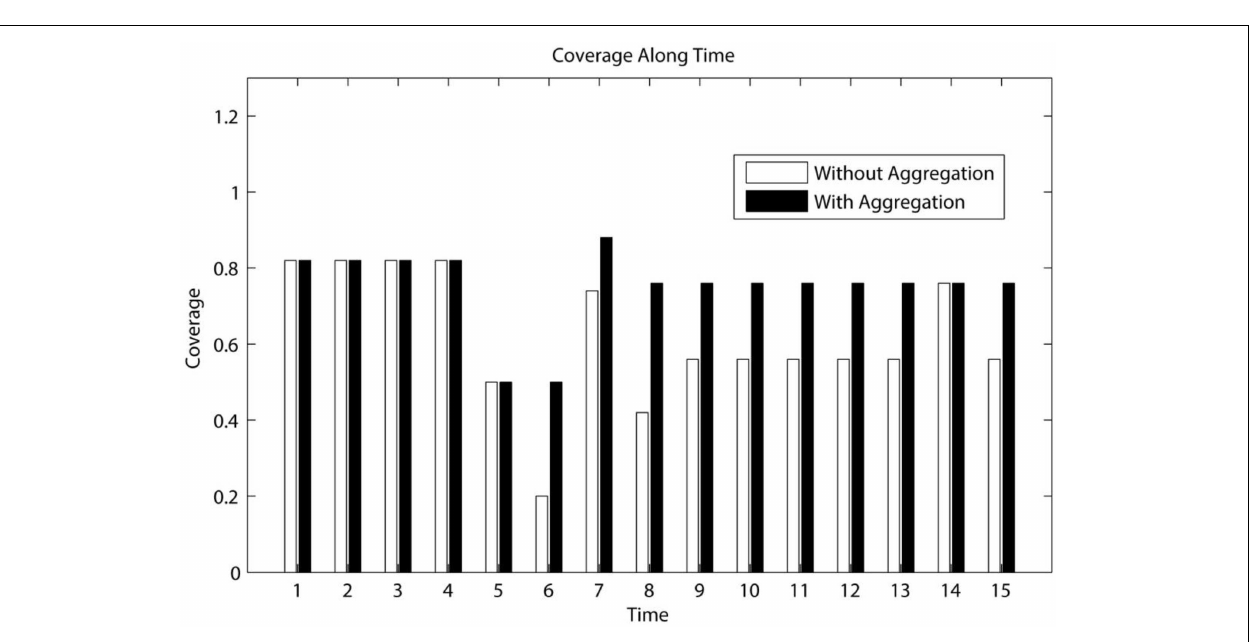
aggregation is considered. These results are ρ A ( t ) = 0.42, and ρ I ( t ) = 0.76, showing a much higher coverage